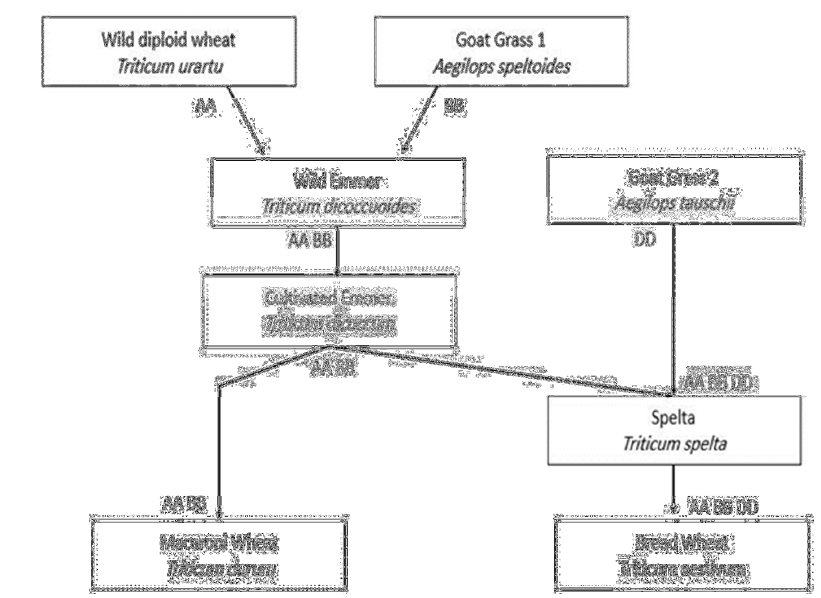
Fig. 1. Evolution of domesticated wheat (Peng et al. ,